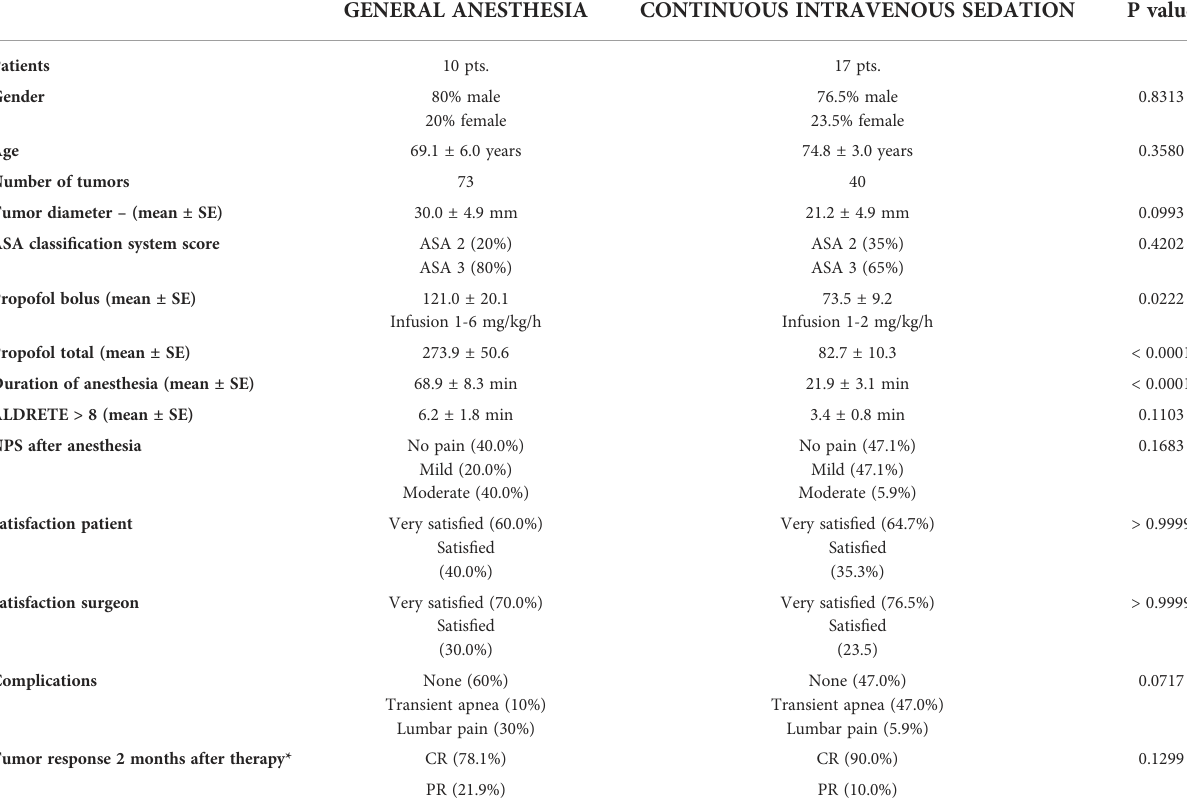
TABLE 1 Patient demographics, procedure characteristics, patient compliance and short-term